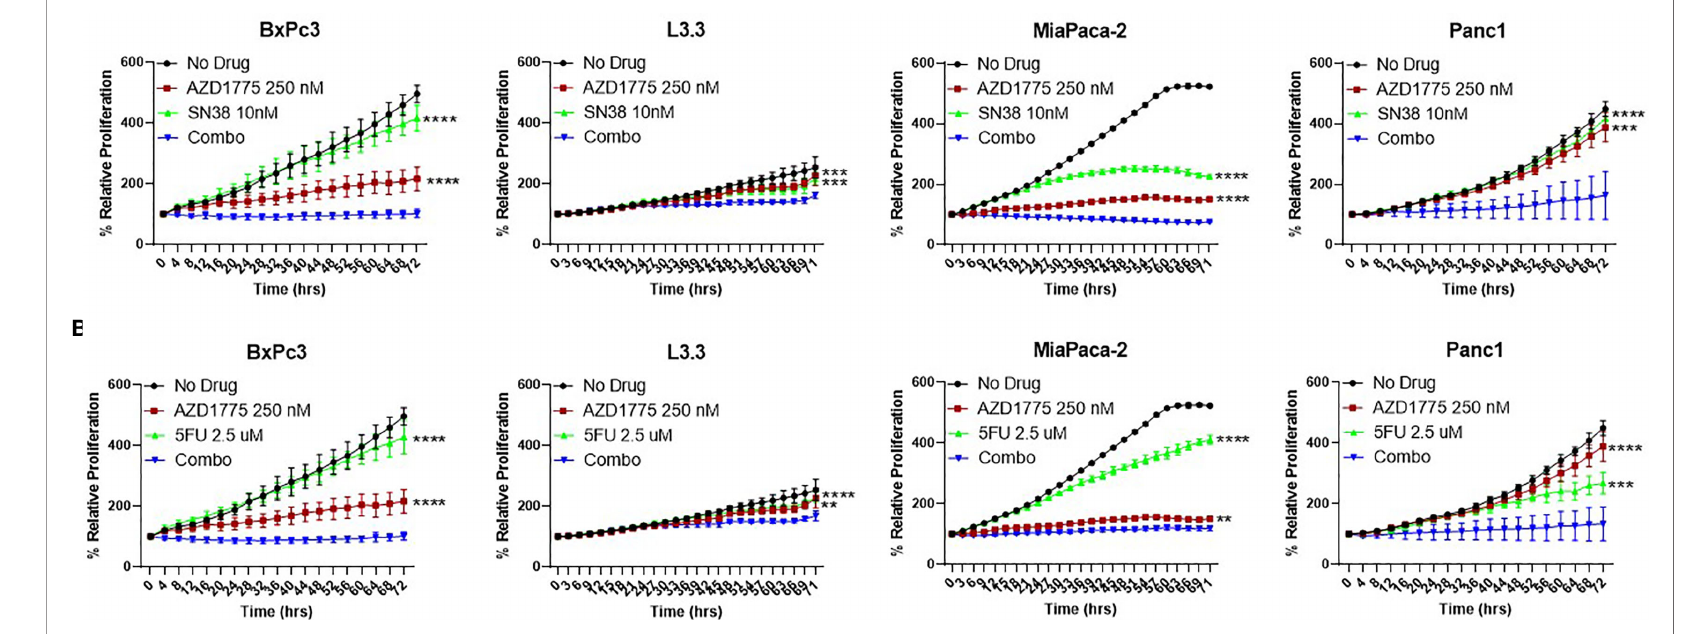
FIGURE 3 | Anti-proliferative effects of AZD1775 (250 nM) and (A) SN38 or (B) 5-FU in PDAC cell lines. BxPc3 (p53 MT ), L3.3 (p53 MT ), MiaPaca-2 (p53 MT ), and Panc1 (p53 MT ) were treated with AZD1775 and SN38 or 5-FU, and proliferation was measured over a 72 hour period using the IncuCyte Zoom with data normalized to hour 0. Data were analyzed with a t-test to compare single agents to the combination (** = p ≤ 0.01, *** = p ≤ 0.001, **** = p ≤ 0.0001). Statistical signi fi cance between the single agent and combination is indicated next to the single